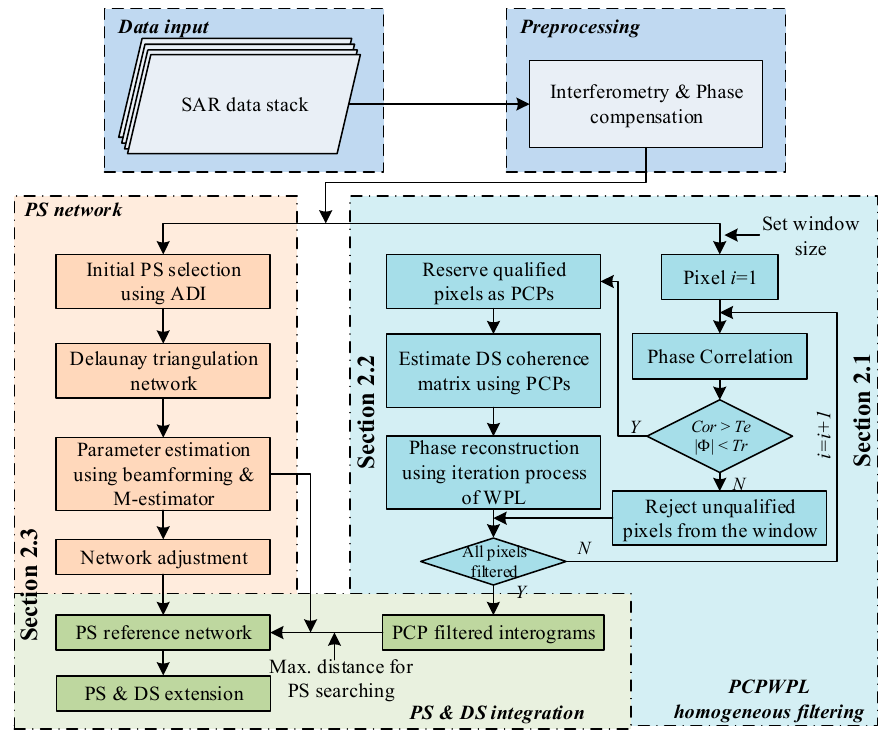
Figure 3. Flowchart of the proposed procedure for PS and DS integration using PCPWPL homogeneous filtering.